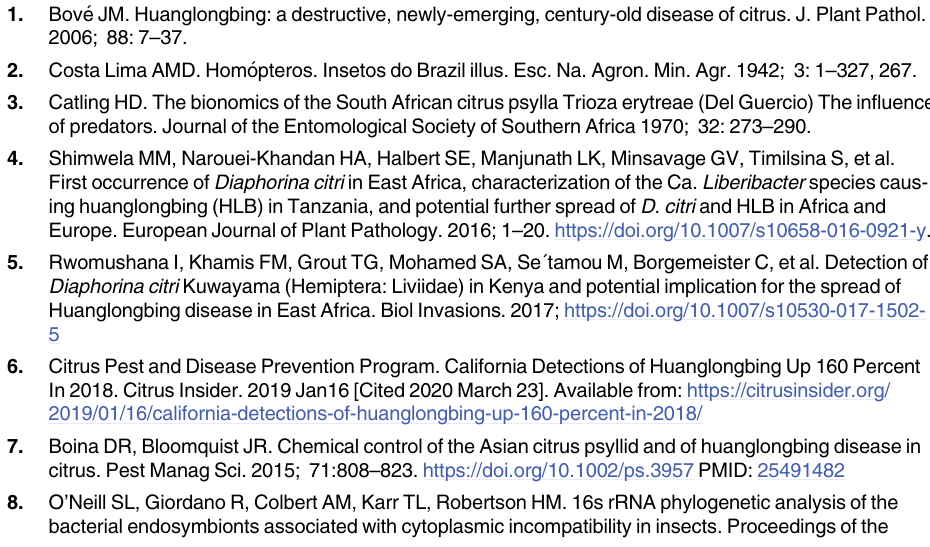
S4 Table. Alpha diversity statistics for the bacterial metagenomes of the citrus psyllid Dia- phorina citri collected in three countries (China, Kenya and Tanzania). S5 Table. Summary statistics for the analyses of the presence of genes for antibiotic resis- tance in the microbiome of the citrus psyllid Diaphorina citri in three countries, obtained from the ARMA workflow in